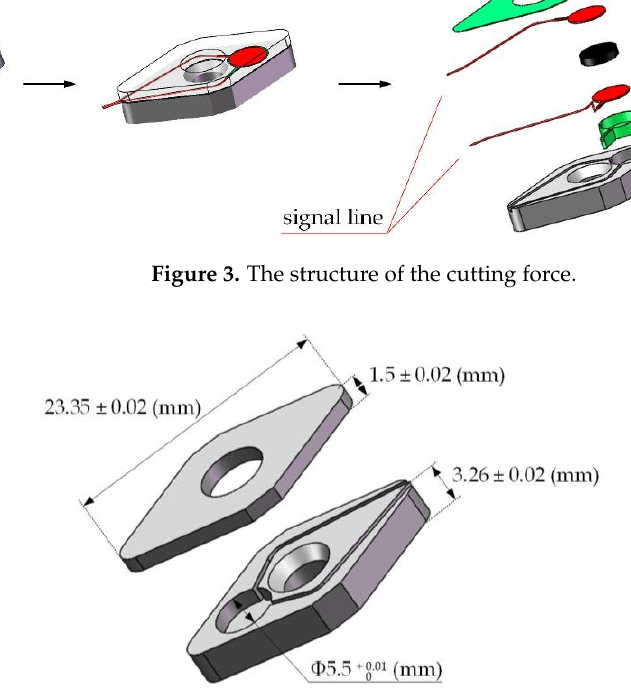
Figure 4. Dimensions of the substrate and cover plate.